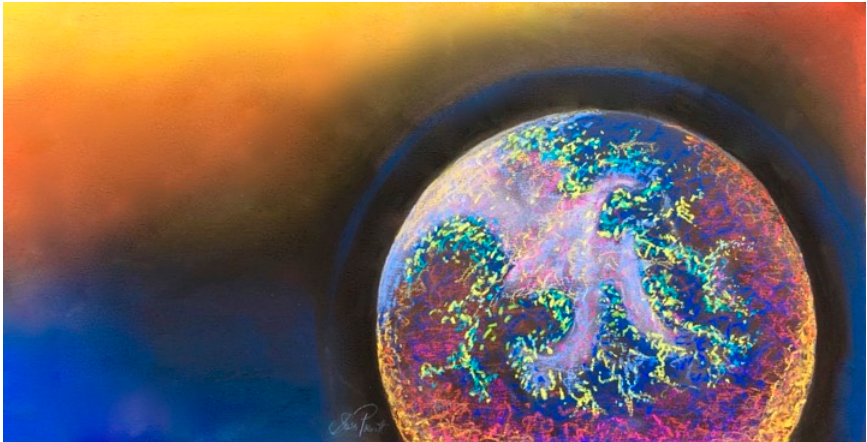
Figure 3. New worlds discovered, teaming with life where we never expected it. More than 100,000 life forms were discovered on a single grain of sand from the North Sea—with complex carbon, nitrogen and sulfur cycles for nutrient production and filter systems. Artwork by S.L.P, inspired by micrographic photography by Probandt, et al. [22].